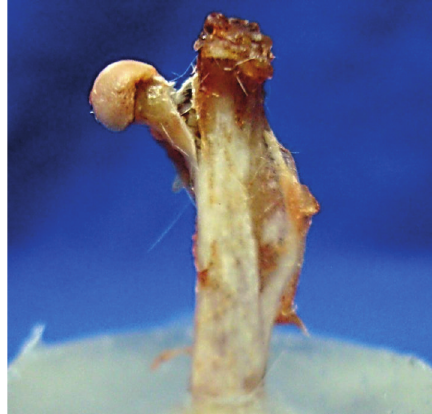
Figure 3: Bone breaking point.